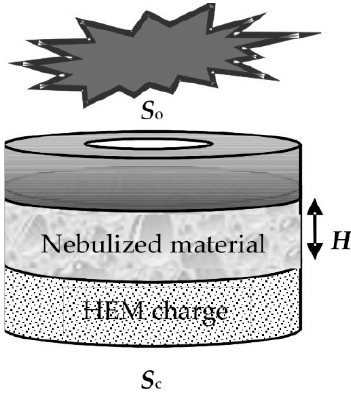
Figure 1. Scheme of the pulse atomizer design: an explosive charge is located in the lower part of the cylindrical body; a layer of the nebulized material is limited by an explosion-destroying membrane. H is the height of the material layer, S o is the area of the nozzle and S c is the cross-sectional area of the cylinder.